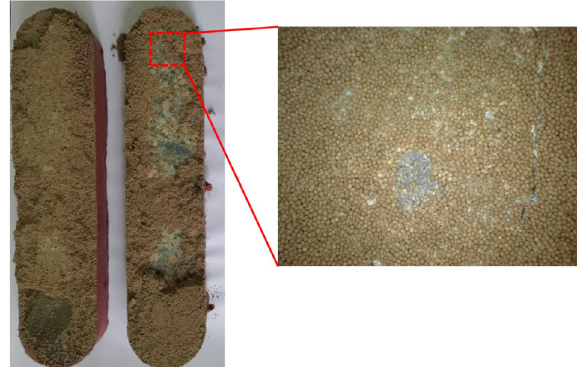
Figure 5. Crushing and embedment of ceramic proppants in reservoir rock plates after a long-term fracture conductivity test.